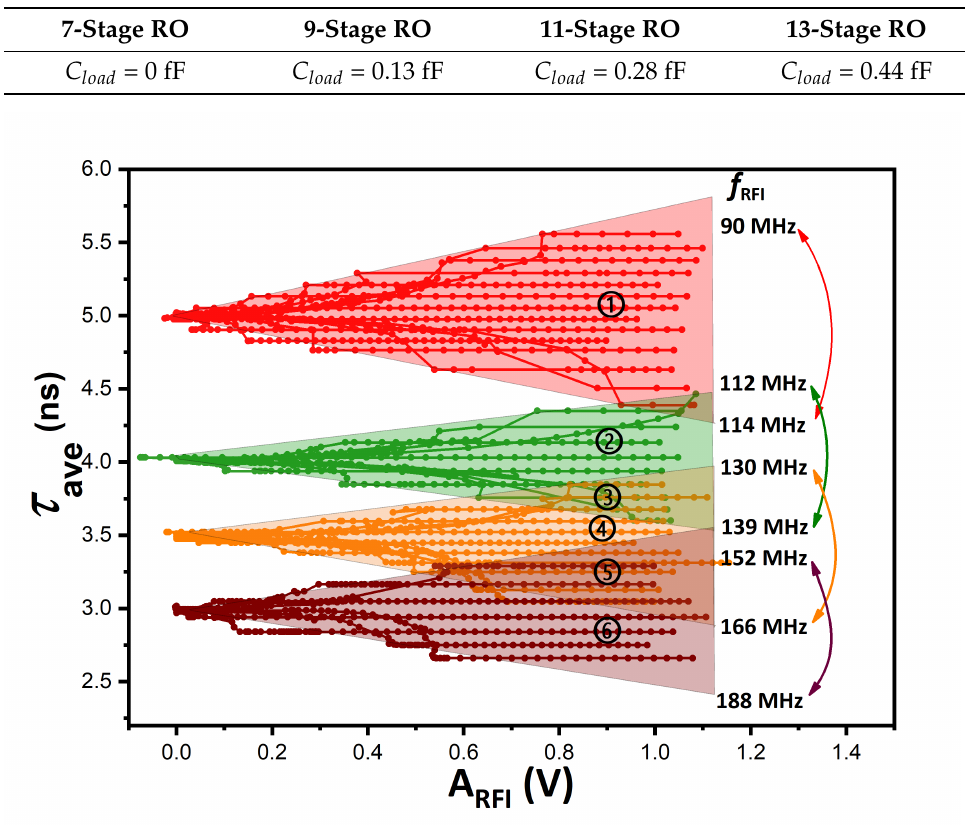
Table 6. Capacitor-load arrangement.